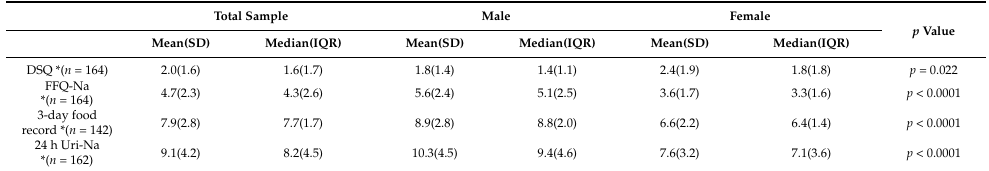
Table 3. Dietary intake of sodium from the DSQ, the FFQ-Na, the 3-day food record and the 24 h Uri-Na. TotalSample